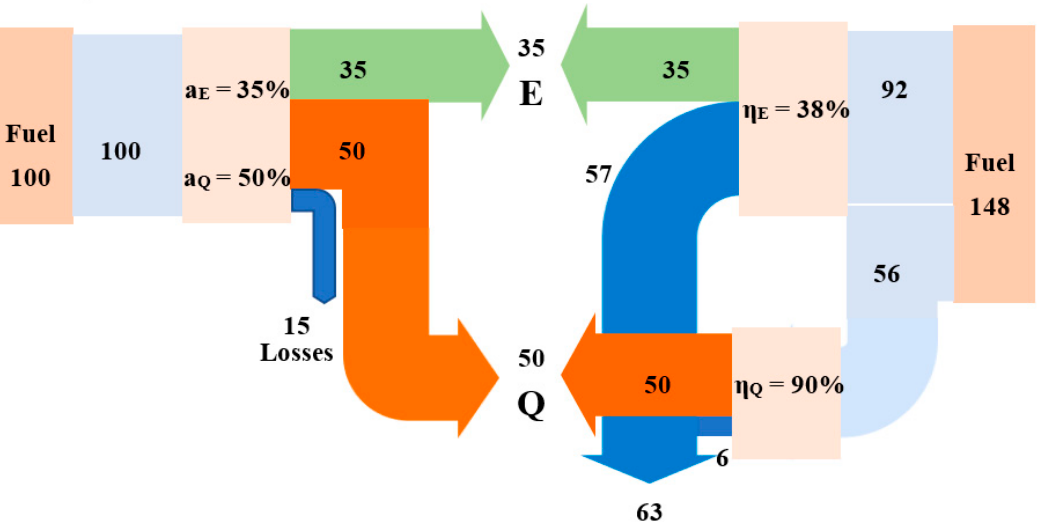
Figure 2. Comparison of the cogeneration unit performance with that of the conventional system [2]. The order of magnitude of the primary energy saving for the same useful heat